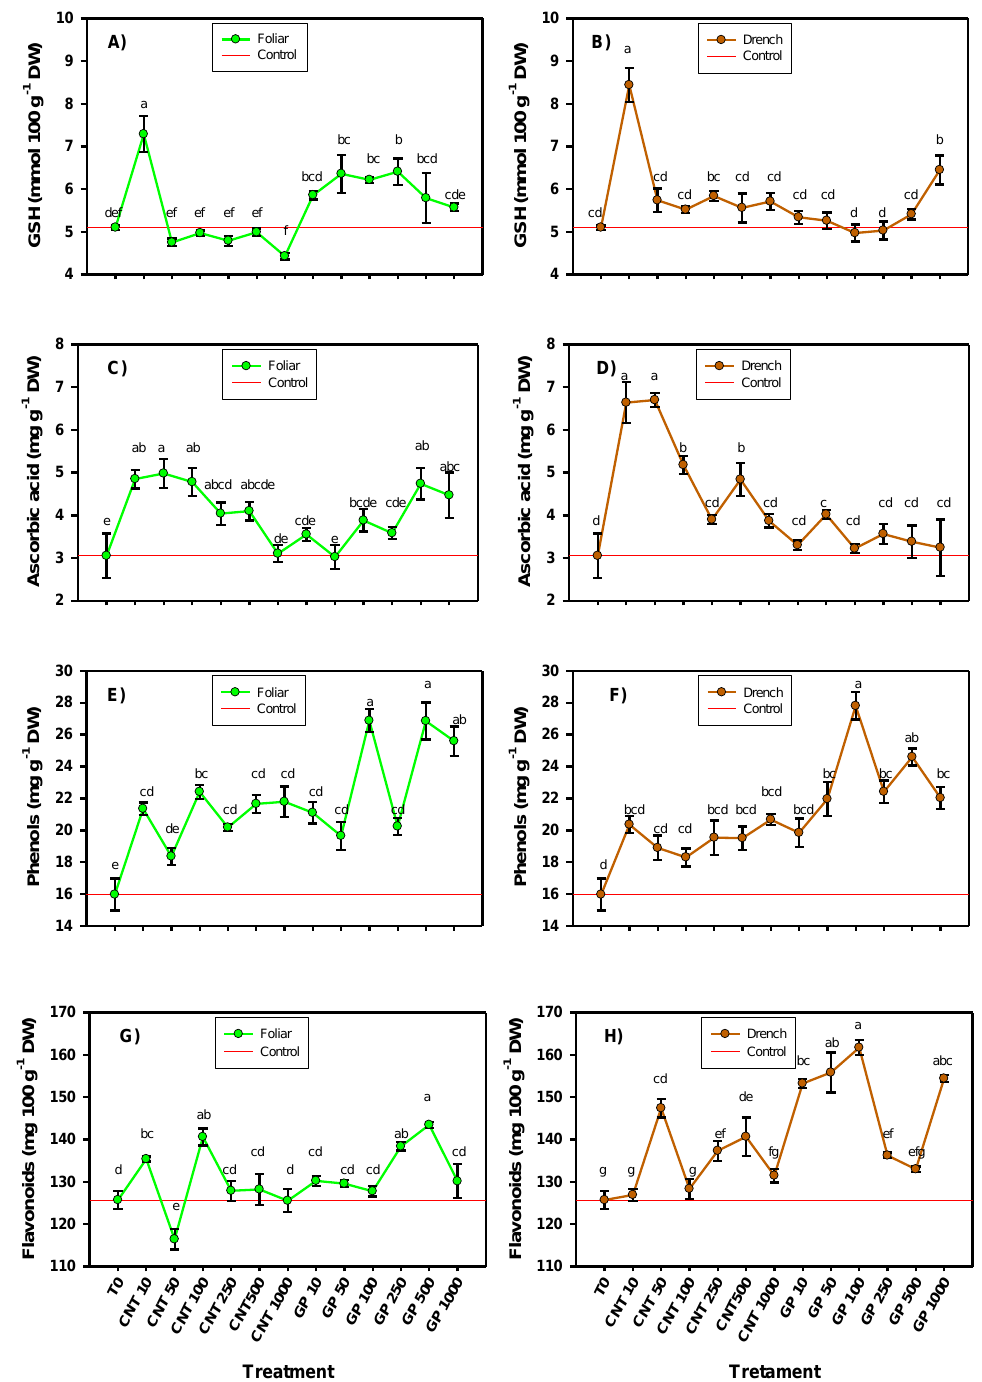
Figure 3. Glutathione ( A , B ), ascorbic acid ( C , D ), phenols ( E , F ), and flavonoids ( G , H ) in tomato seedlings with the application of carbon nanomaterials. T0: control; CNTs: carbon nanotubes; GP: graphene; DW: dry weight; 10, 50, 100, 250, and 500 represent the mg L − 1 applied of each carbon nanomaterial. Di ff erent letters indicate significant di ff erences among treatments according to Duncan ( α = 0.05). n = 5 ± standard error.